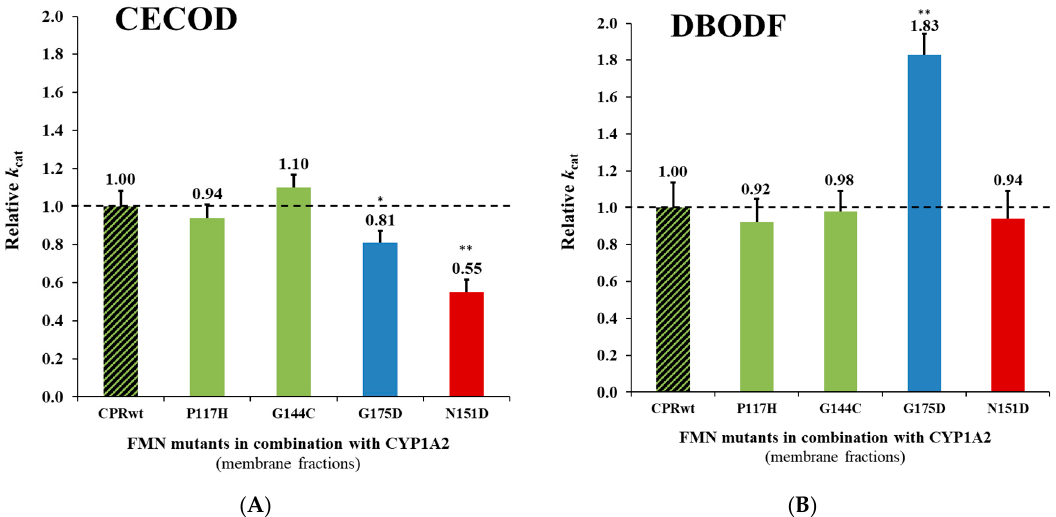
Figure 2. Relative turnover rates ( k cat ) (x fold) of the CPR mut :CYP1A2 CECOD ( A ), and DBODF ( B ) activities, normalized by the k cat demonstrated by CPR wt / CYP (determined in membrane fractions) (technical replicates N = 3). CPR ‐ FMN ‐ domain wildtype (CPR wt :CYP, black stripes). CPR ‐ FMN ‐ domain mutants previously demonstrated to support a gain in CYP1A2 ‐ mediated EROD ‐ (P117H and G144C, green), CYP2A6 ‐ mediated C7H ‐ (G175D, blue), and CYP3A4 ‐ mediated DBODF ‐ activity (N151D, red). k cat values of the CPR mut / CYP1A2 were compared with the ones of the CPR wt / CYP1A2 applying the unpaired t test (** p < 0.005; * p < 0.05).